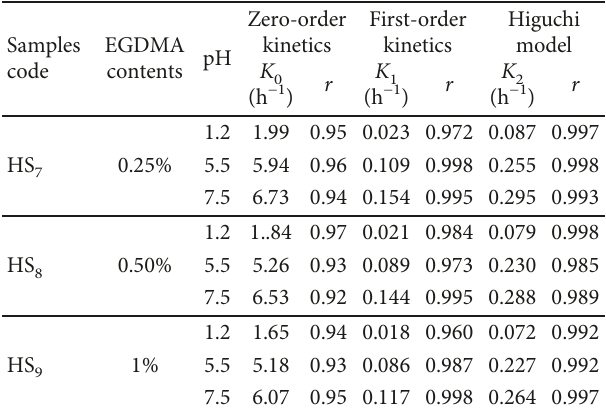
Table 6: E ff ect of degree of crosslinking on the drug release kinetics of Poly (CMCS- g -AA) hydrogels in the solutions of di ff erent pH values.